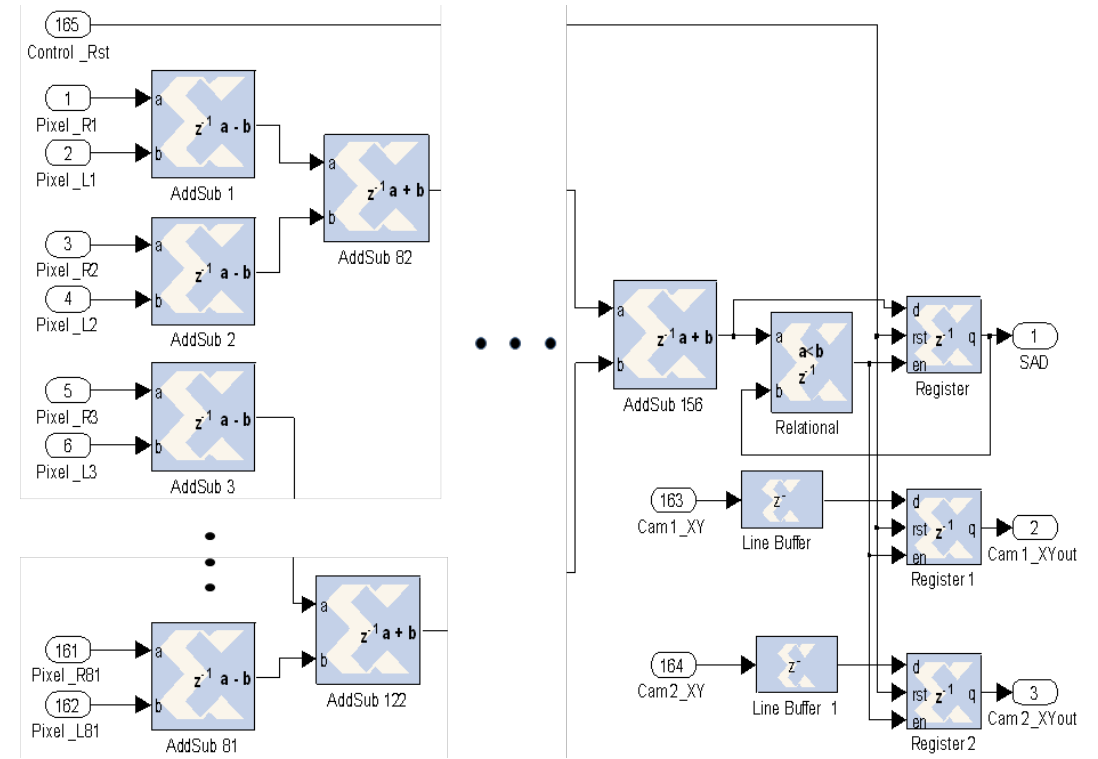
Figure 10. Correlation implementation.